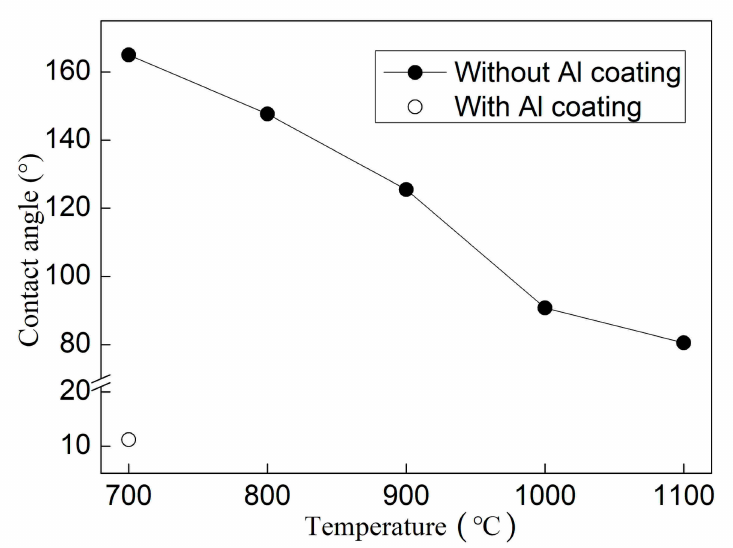
Figure 5. The contact angle change of molten aluminum on the two kinds of sample.